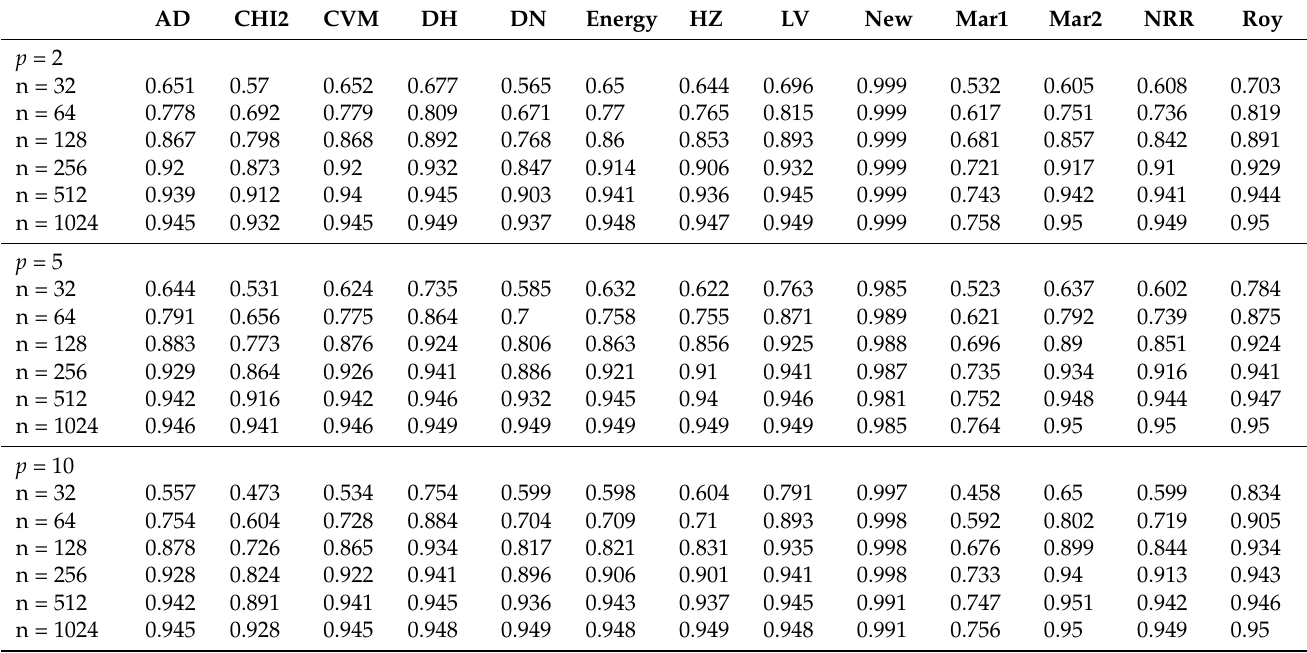
Table 2. An average empirical power for a group of symmetric